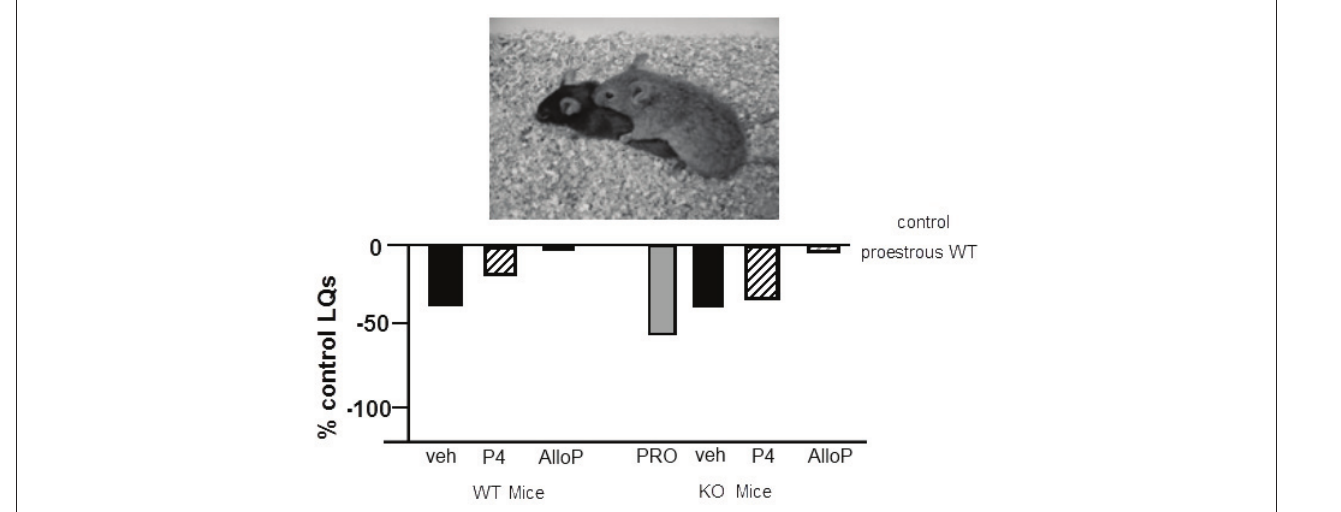
background. This strain of mice is commercially available from Taconic. Data are represented as a percent of the WT proestrous control group. A picture of lordosis is included above the data bars. PXRKO mice have lower lordosis than do WT mice across hormone conditions, except for with replacement back of